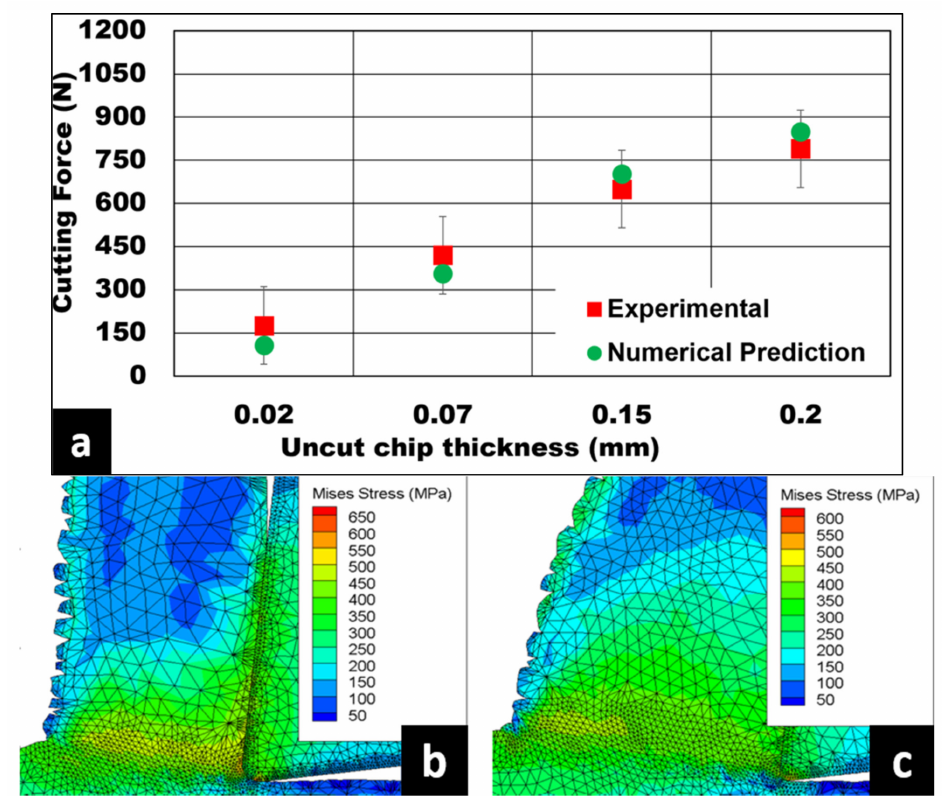
Figure 5. ( a ) Effect of undeformed chip thickness of 6061/hollow alumina shell syntactic foams on machining forces (AdvantEdge TM simulation) (vol% = 10%, Vc = 50 m/min, b = 3 mm); Von Mises stress contour at ( b ) h = 0.07 mm and ( c ) h = 0.2